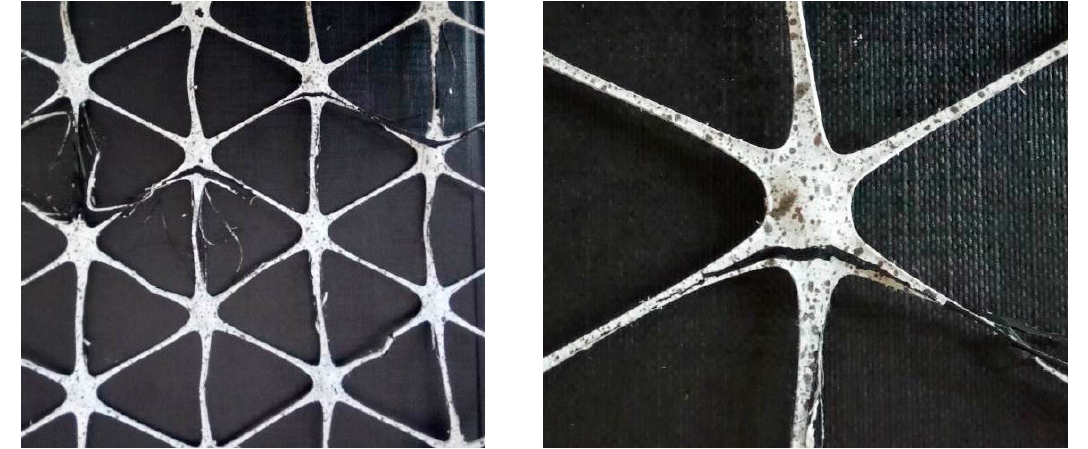
Figure 21. The central part of the polypropylene geogrid sample after the tensile test with a visible destroyed geogrid node [38].